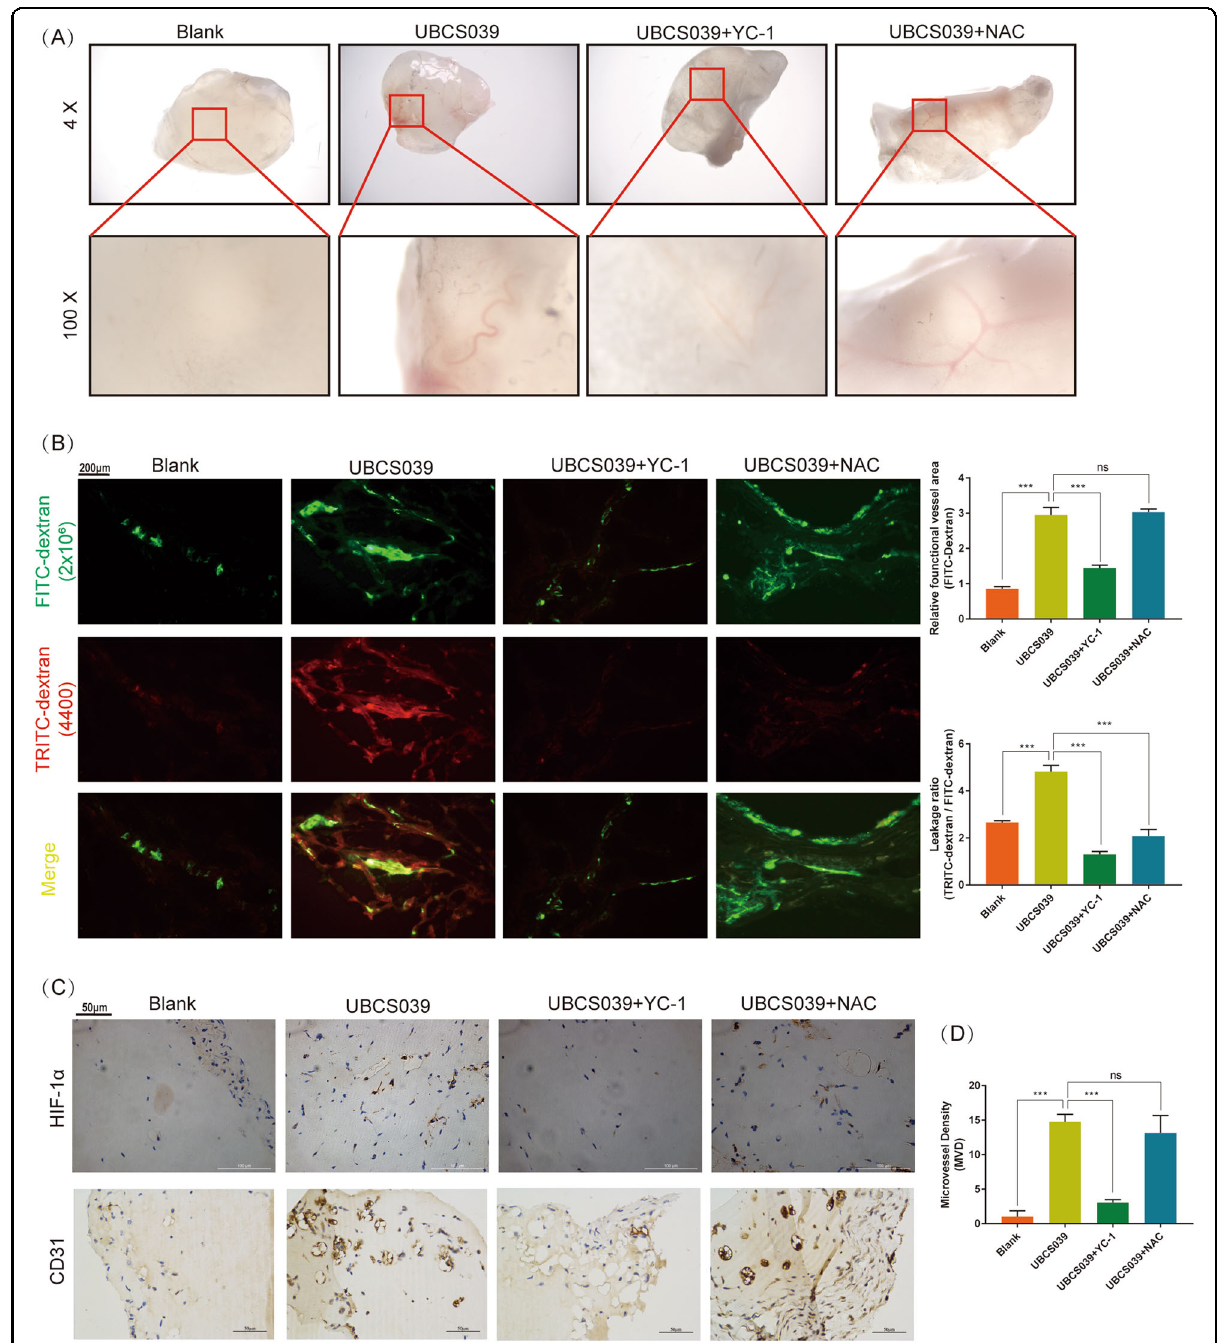
Fig. 7 SIRT6 promoted angiogenesis as well as vessel permeability in vivo ( N = 5, each group). A Matrigel plugs deprived from mice after 14 days of subcutaneous implantation. UBCS039: SIRT6 activator, 100 μ m; YC-1: HIF-1 α inhibitor, 2 μ m; NAC: ROS scavenger, 10 μ m. All drugs were blended with Matrigel gel before implantation. B FITC-dextran (2 × 10 6 MW) accompanied by TRITC-dextran (4400 MW) was injected before the scari fi cation of mice. FITC-dextran (2 × 10 6 MW): functional vessel, TRITC-dextran (4400 MW): leaky blood cells from vessels. TRITC-dextran/FITC- dextran area (leakage ratio): vessel permeability (magni fi cation: ×100). C Expression of HIF-1 α and microvascular density (MVD, marked by CD31) of all matrigel plugs performed by IHC (magni fi cation: ×400) (ns: no signi fi cance, *** P <